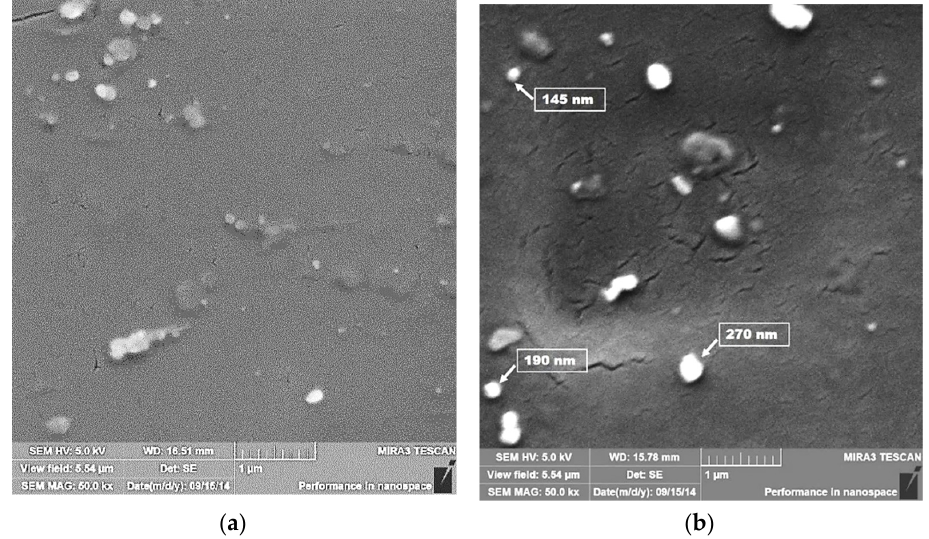
Figure 10. SEM–FEG of the film’s fracture surface produced by mechanical alloying powder for 4 h. ( a ) PVA + 2.5% wt. Ag and ( b ) PVA + 10% wt.